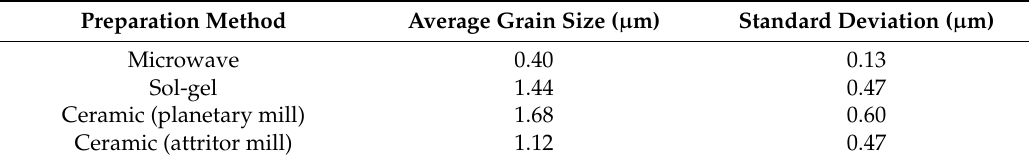
Table 1. Average grain size of the manganites prepared by the different